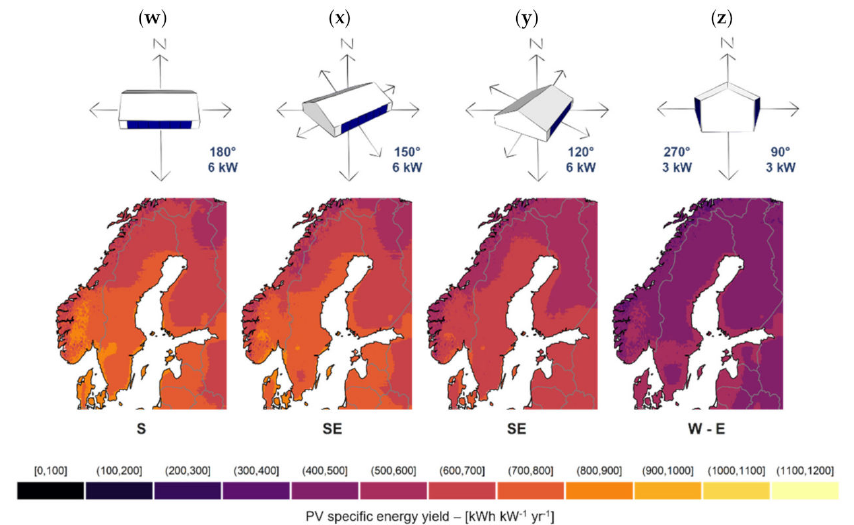
Figure 9. Yearly PV specific energy yield (E rel,PV , kWh · kW − 1 · yr − 1 ) maps of the Nordic and Baltic countries for wall-mounted PV systems at a 90 ◦ slope with an installed peak power (P PV,STC ) of 6 kW. The values were estimated using PVGIS version 5.1 assuming the solar cell technology was c-Si and the estimated system losses were 14%. The irradiance values used were from the ECMWF-ERA-5 dataset with a coverage period of 2005–2016 retrieved as a 0.1 ◦ × 0.1 ◦ grid both in latitude and longitude, extending from 54.5 ◦ N to 70 ◦ N in latitude and 4.5 ◦ E to 31.5 ◦ E in longitude. Depending on the orientation of the building and the distribution of the PV modules, the studied system designs were: ( w ) 6 kW at azimuth 180 ◦ ; ( x ) 6 kW at azimuth 150 ◦ ; ( y ) 6 kW with azimuth 120 ◦ ; ( z ) 3 kW at azimuth 90 ◦ combined with 3 kW at azimuth 270 ◦ .